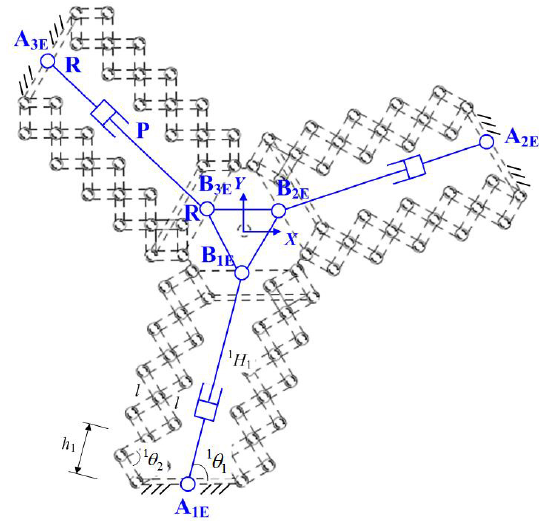
Figure 5. Simplified translational parallel mechanism.